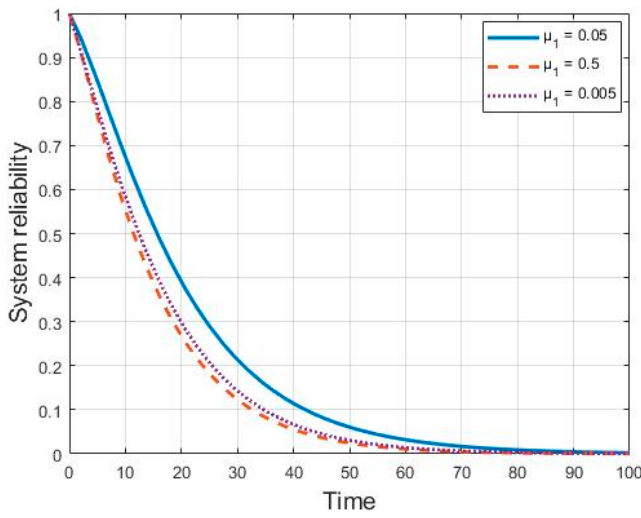
Figure 9. System reliability comparison with the changes of repair rate µ 1 .